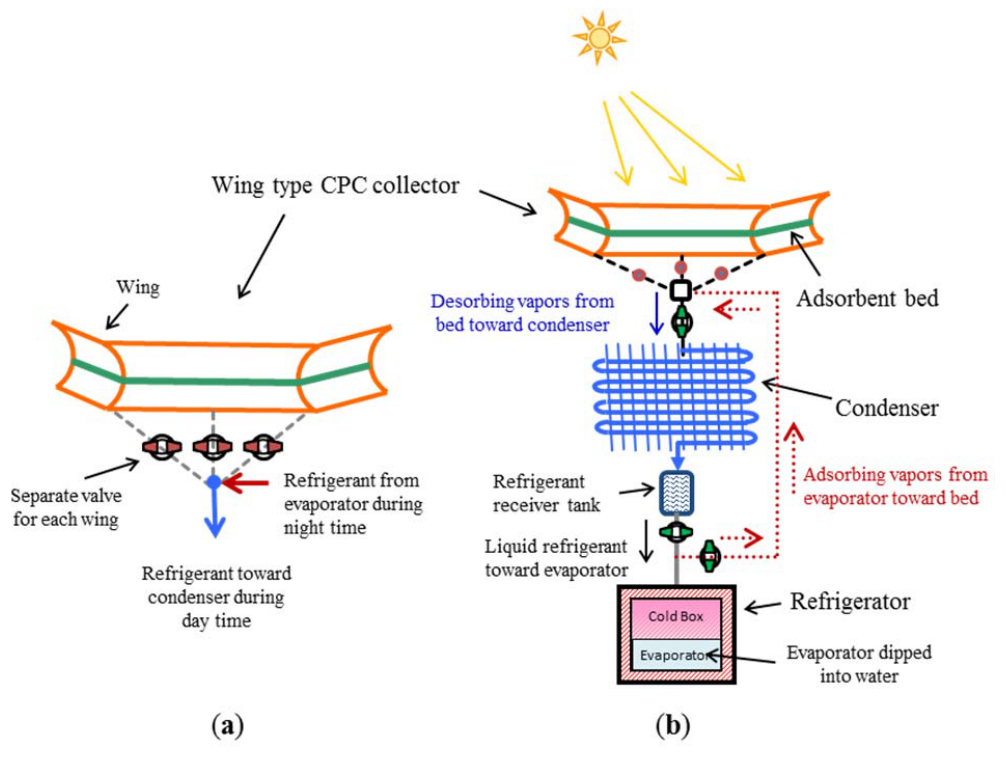
Figure 4. Schematic diagram: ( a ) wing type CPC with separate valve control for each part; and ( b ) system description.